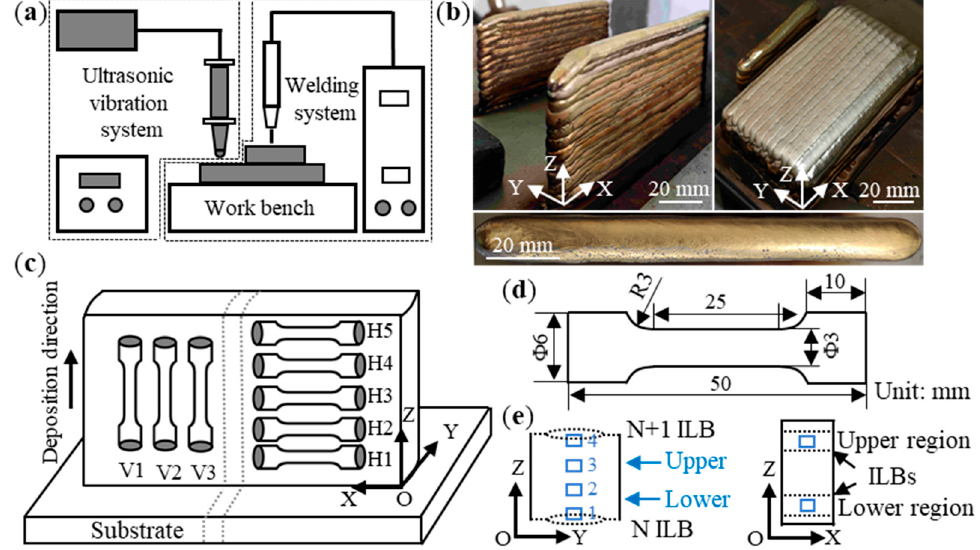
Figure 1. ( a ) Schematic diagram of the experimental apparatus of ultrasonic vibration during WAAM, ( b ) typical WAAM fabricated samples, ( c ) schematic configuration of the sample preparation, ( d ) ( d )dimensionsoftensilespecimensinmm, ( e dimensions of tensile specimens in mm, ( e ) schematic diagram of microstructure observation position.